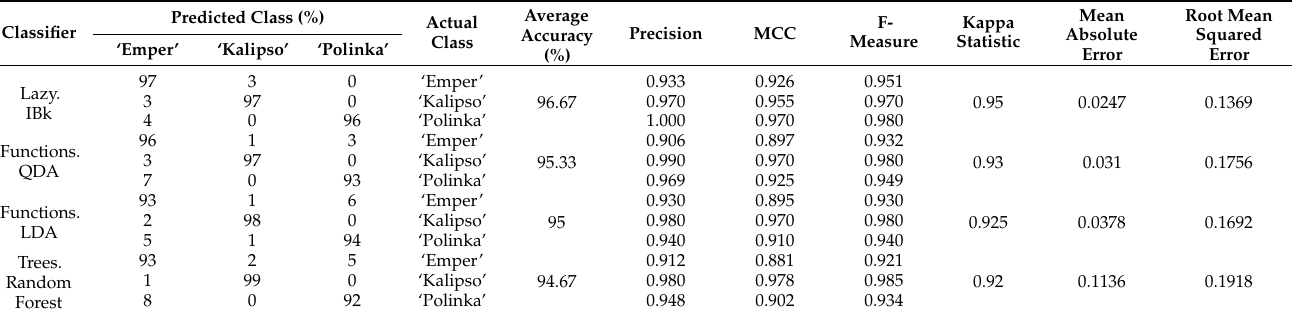
Table 1. The confusion matrices, average accuracies, and values of precision, MCC, F-measure, Kappa statistic, mean absolute error, and root mean squared error of discrimination of plum stones belonging to different cultivars based on models including textures selected from color channels R , G , B , L , a , b , X , Y , and Z